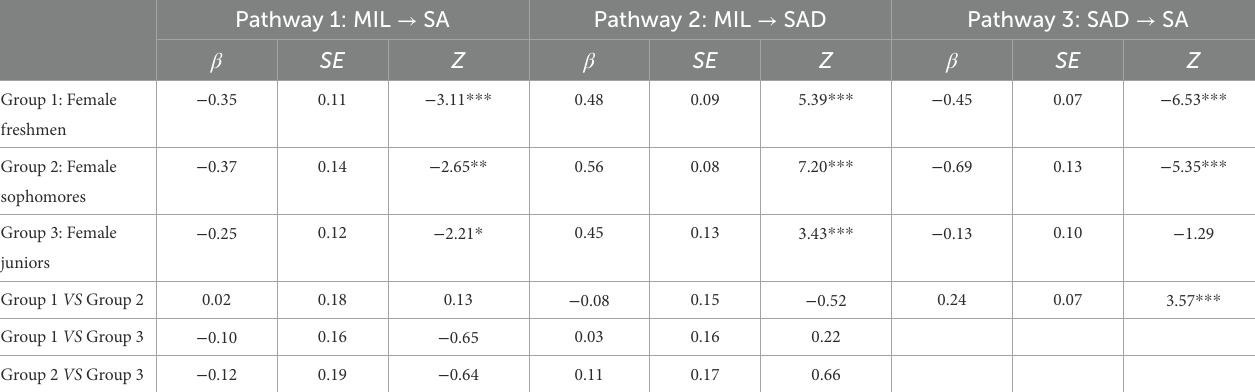
TABLE 6 The results of grade comparison in path coefficients. Pathway 1: MIL → SA Pathway 2: MIL →